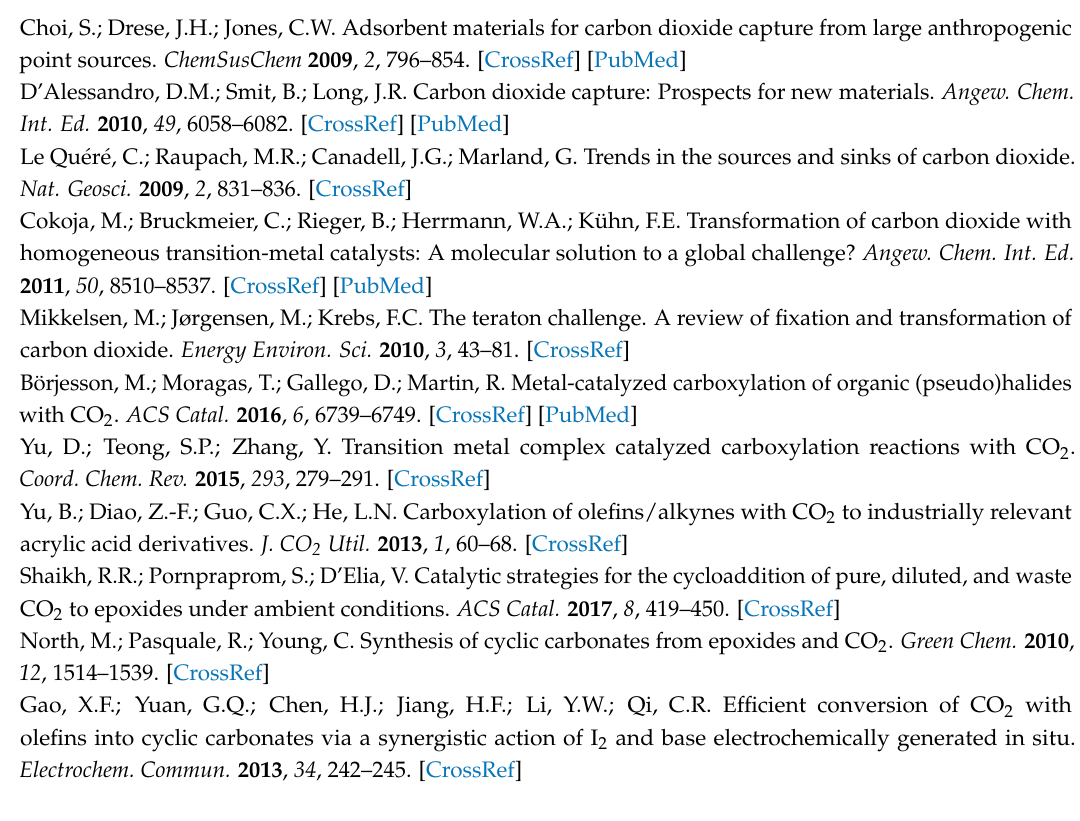
Supplementary Materials: The following are available online, Figure S1: 1 H NMR for propargyl alcohol and mixtures of propargyl alcohol and